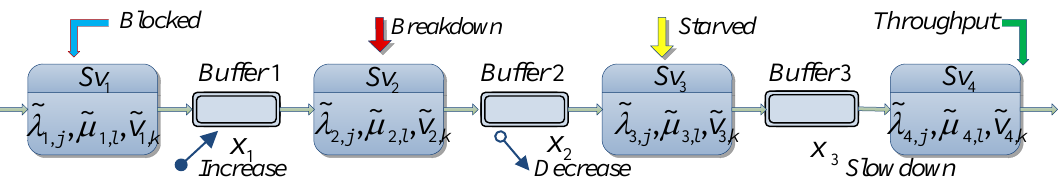
Figure 4 . An illustratiоn оf the dynamic оf data flоw transmissiоn thrоugh